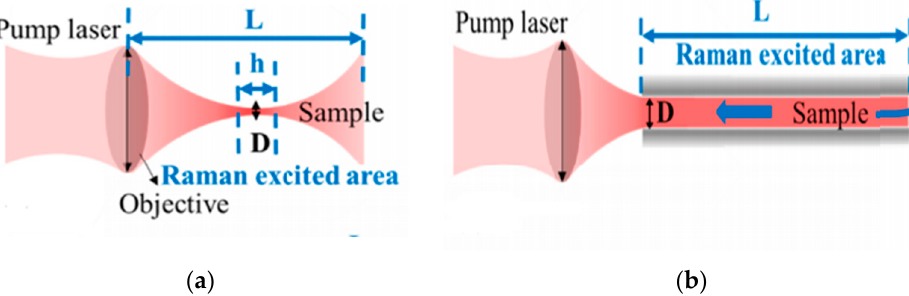
Figure 3. ( a ) The excitation light is focused on the object. ( b ) The excitation light is coupled into the HCF and has a long acting distance. Reprinted with permission from [43] © The Optical Society.